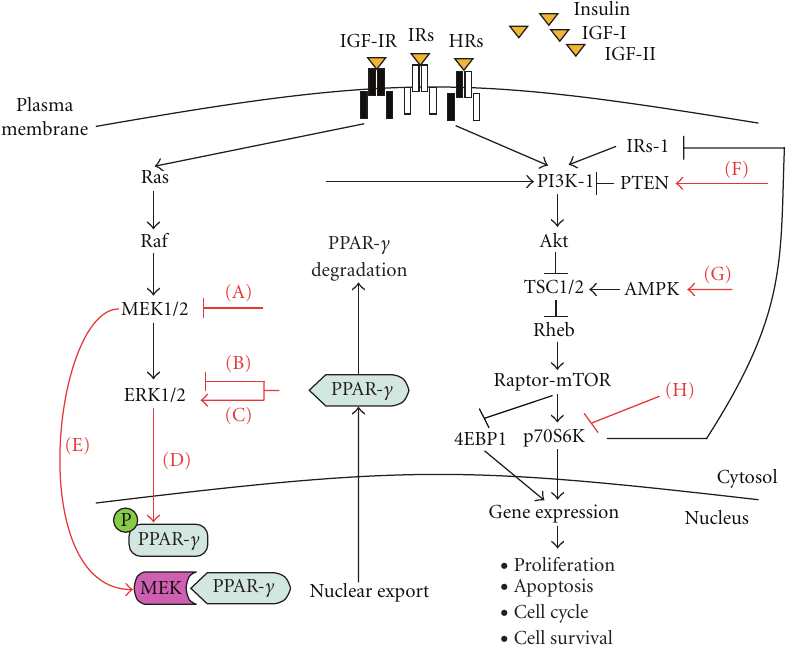
Figure 3: Cross-talk between PPAR- γ and IGF system downstream signaling pathways . The points of interaction between PPAR- γ and MAPK/PI3K pathways occur at di ff erent levels and are indicated as arrows (activation) or bars (inhibition). In some cell contexts PPAR- γ ligands reduce MEK1/2 protein expression (A) and inhibit ERK1/2 phosphorylation (B). However, in other cell systems, PPAR- γ agonists may activate ERK1/2 (C). Alternative mechanisms of interaction between PPAR- γ and MAPK/PI3K pathways include (D) ERK- mediated PPAR- γ phosphorylation at Ser84/114; (E) MEK1/2-dependent PPAR- γ nuclear export followed by PPAR- γ degradation; (F) PTEN upregulation; (G) mTOR downregulation via activation of AMPK; (H) inhibition of p70S6K